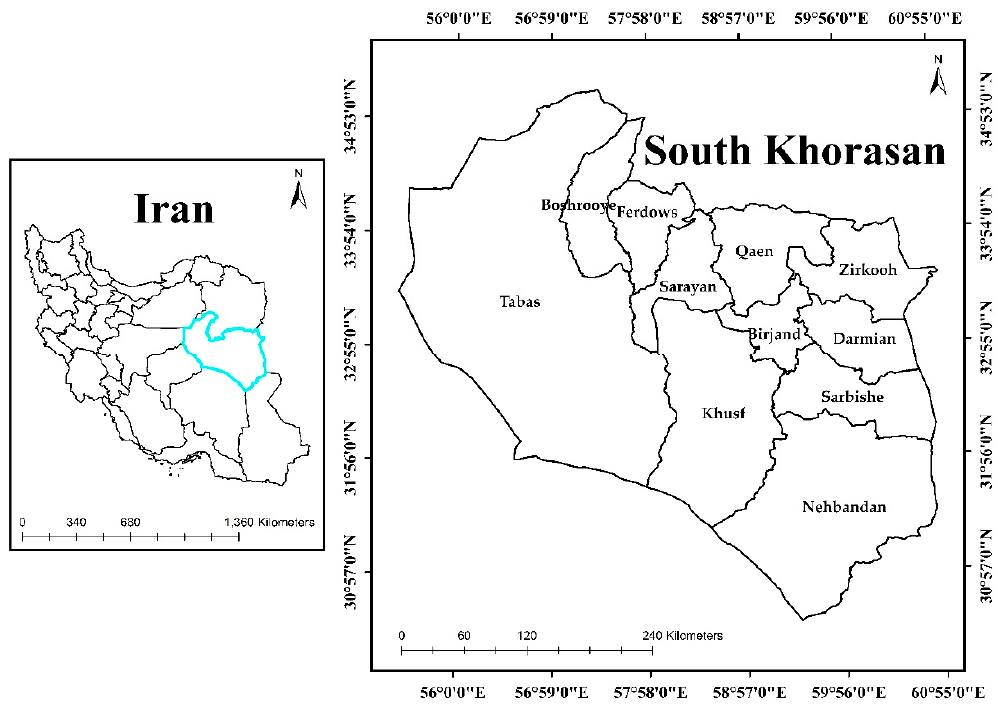
Figure 1. Map of the study area.